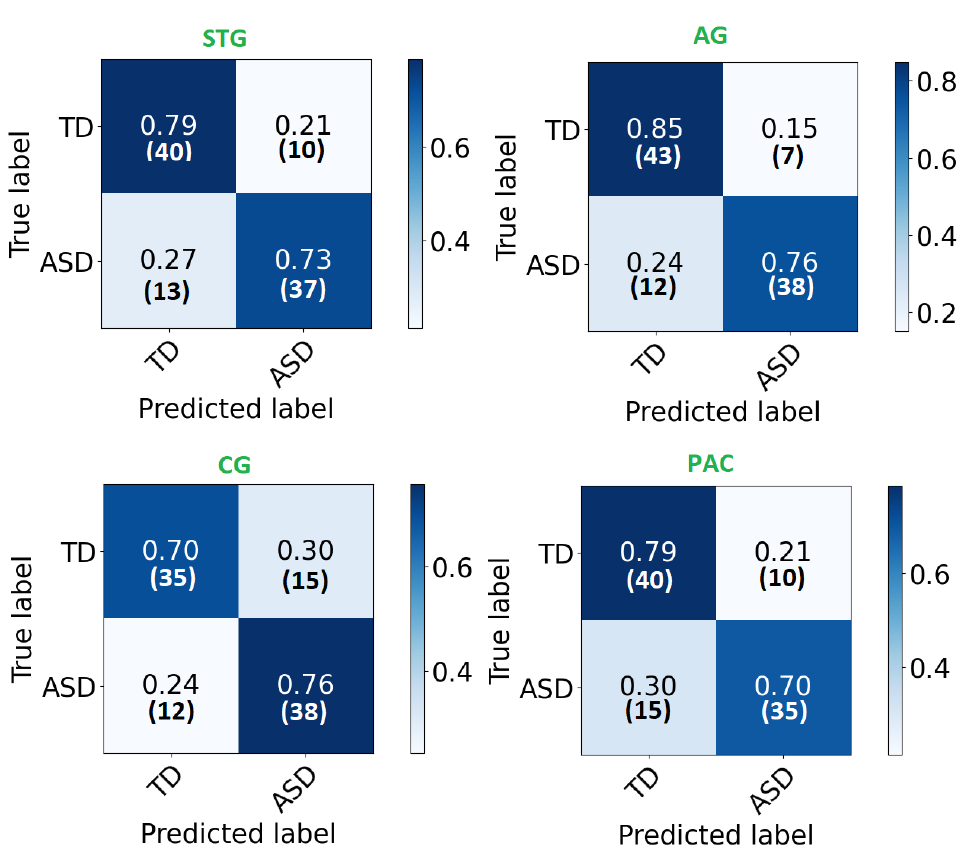
Figure 4. The confusion matrix for each ROI local classifier represented in percentage (number) for each